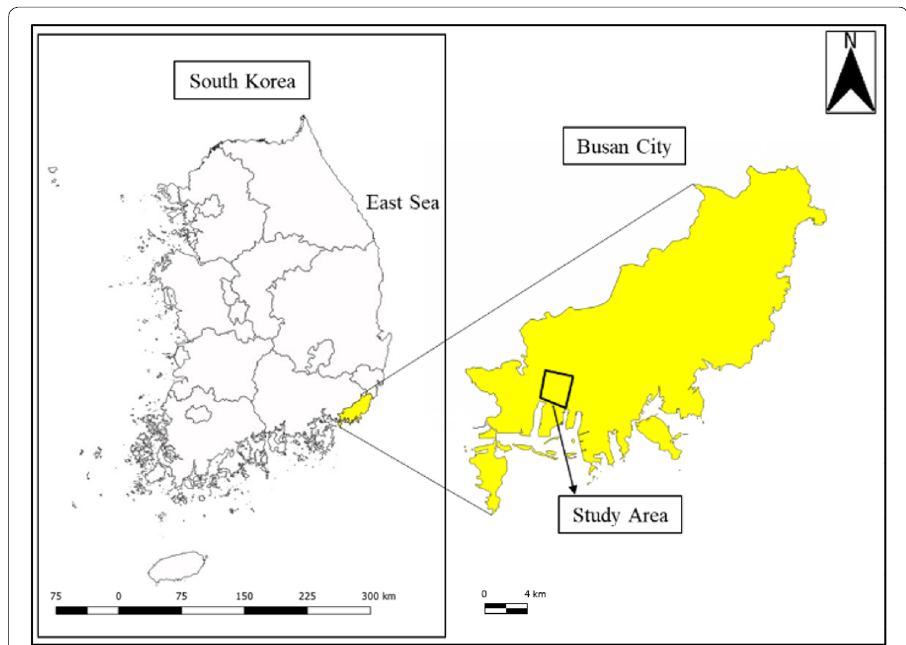
Fig. 1 Location map of the study